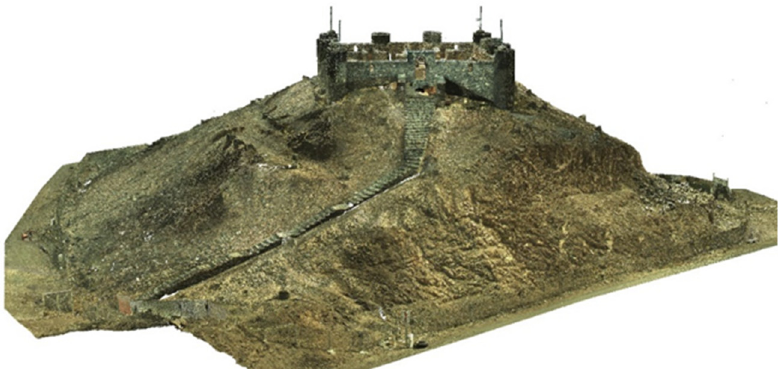
Figure 12. TLS 3D colored point cloud of the Asfan Castle. The use of a TLS-attached camera results in low-resolution color information and poor color homogeneity.